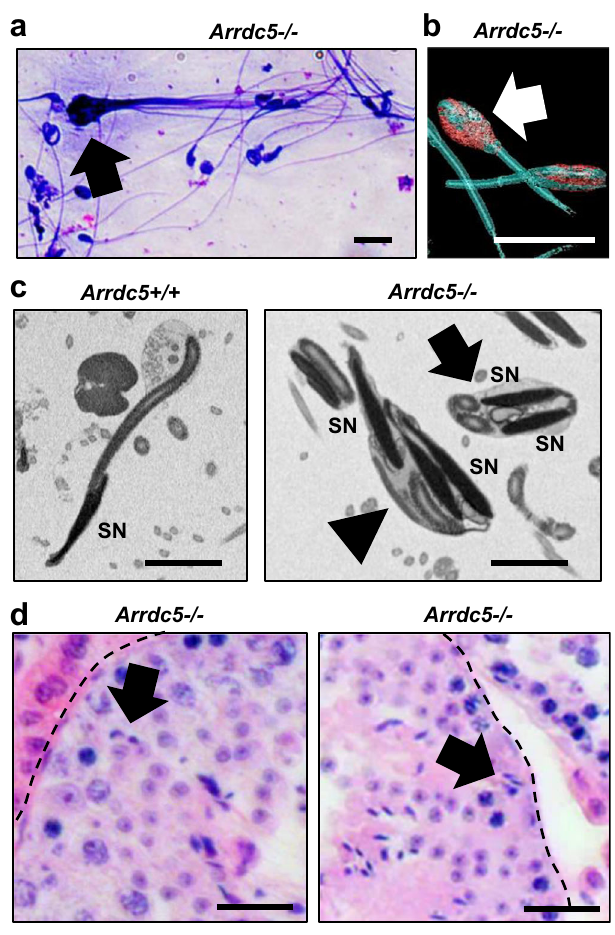
Fig.7|Assessmentofspermiationdefectsin Arrdc5 − / − mice.a DipQuickstained epididymal sperm from adult Arrdc5 − / − mice. Arrow indicates a conglomerate of sperm thathave been prematurely released from the seminiferous epithelium. Bar is 10 μ m. b Three-dimenional scanning electron microscopy for epididymal sperm from adult Arrdc5 − / − mice with an enlarged head wrapped in residual cytoplasm (arrow). Bar is 10 μ m. c Transmission electron microscopy for epididymal sperm from adult Arrdc5 + /+ and Arrdc5 − / − littermates. Sperm heads with multiple nuclei (SN) that are interconnected (arrow) or enfolded by cytoplasm (arrowhead) were observed for Arrdc5 − / − mice, an oddity that is not observed with sperm from Arrdc5 + /+ mice. Barsare 5 μ m. d Seminiferous tubule cross-sections from testes of adult Arrdc5 − / − mice in which elongated spermatids (indicated by arrows) are embedded deep in the seminiferous epithelium. Bars are 25 μ m and dashed lines indicateseminiferoustubulebasementmembrane.Allimagesarerepresentativeof three independently repeated